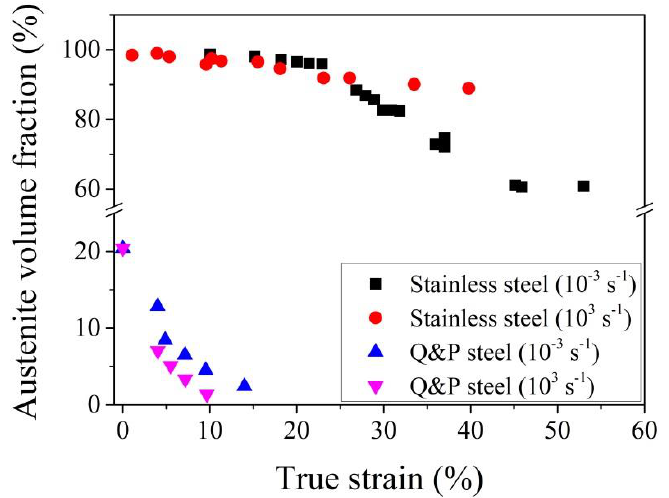
Figure 8. Evolution of austenite volume fraction in stainless steel [112] and quenching and partitioning (Q&P) steel [138] at different strain rates. (Q&P) steel [138] at di ff erent strain